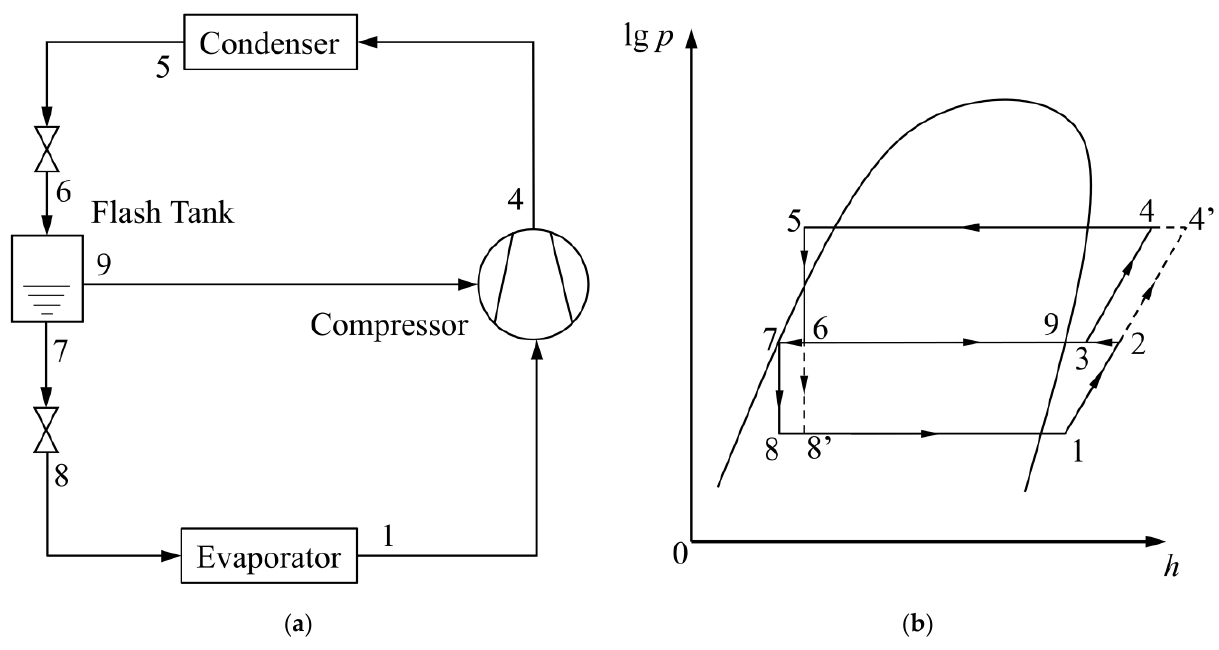
Figure 1. Schematic diagram and pressure-enthalpy diagram of vapor injection system: ( a ) schematic diagram of vapor injection system; ( b ) pressure-enthalpy diagram of vapor injection system.